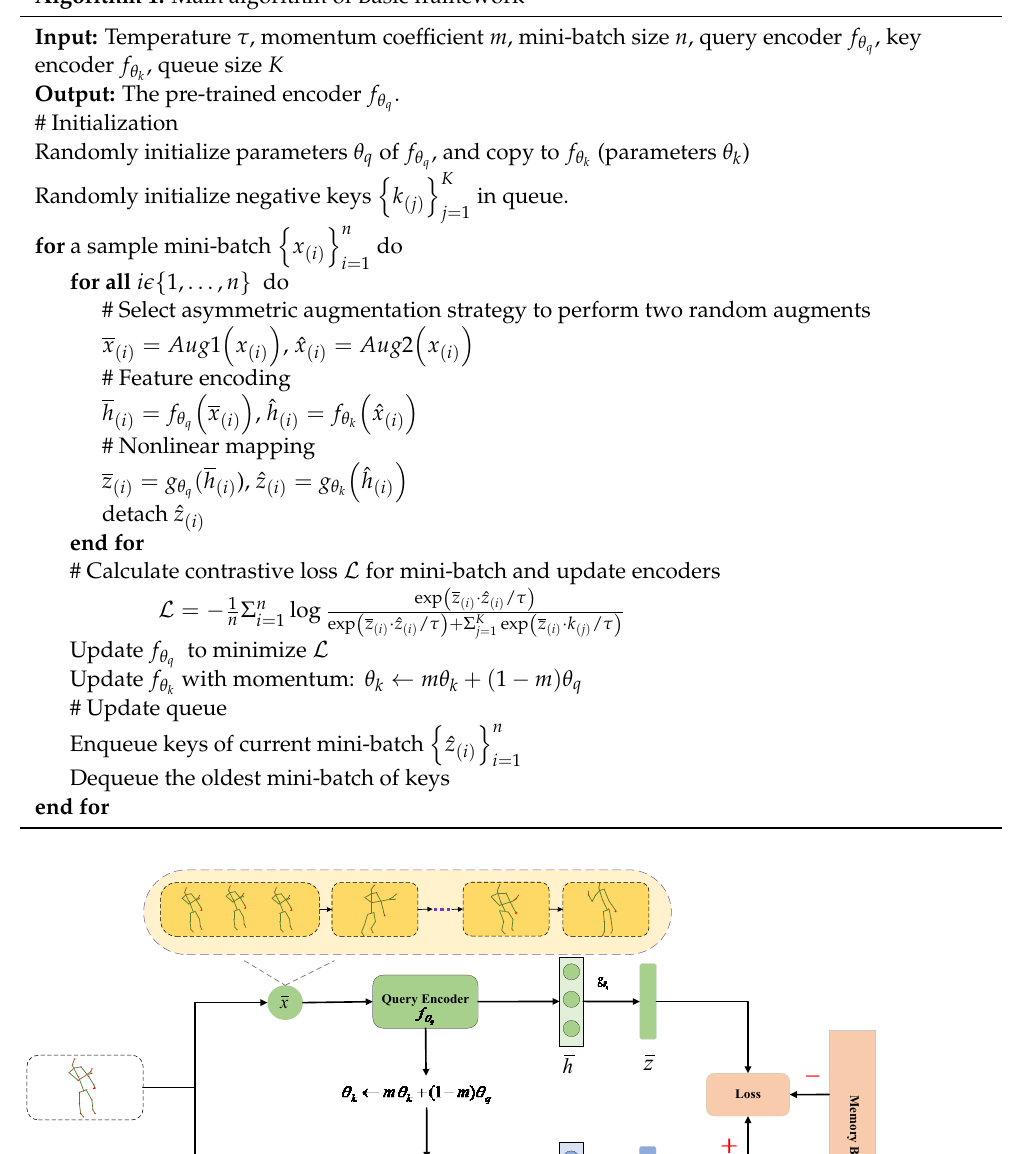
Algorithm 1. Main algorithm of Basic framework